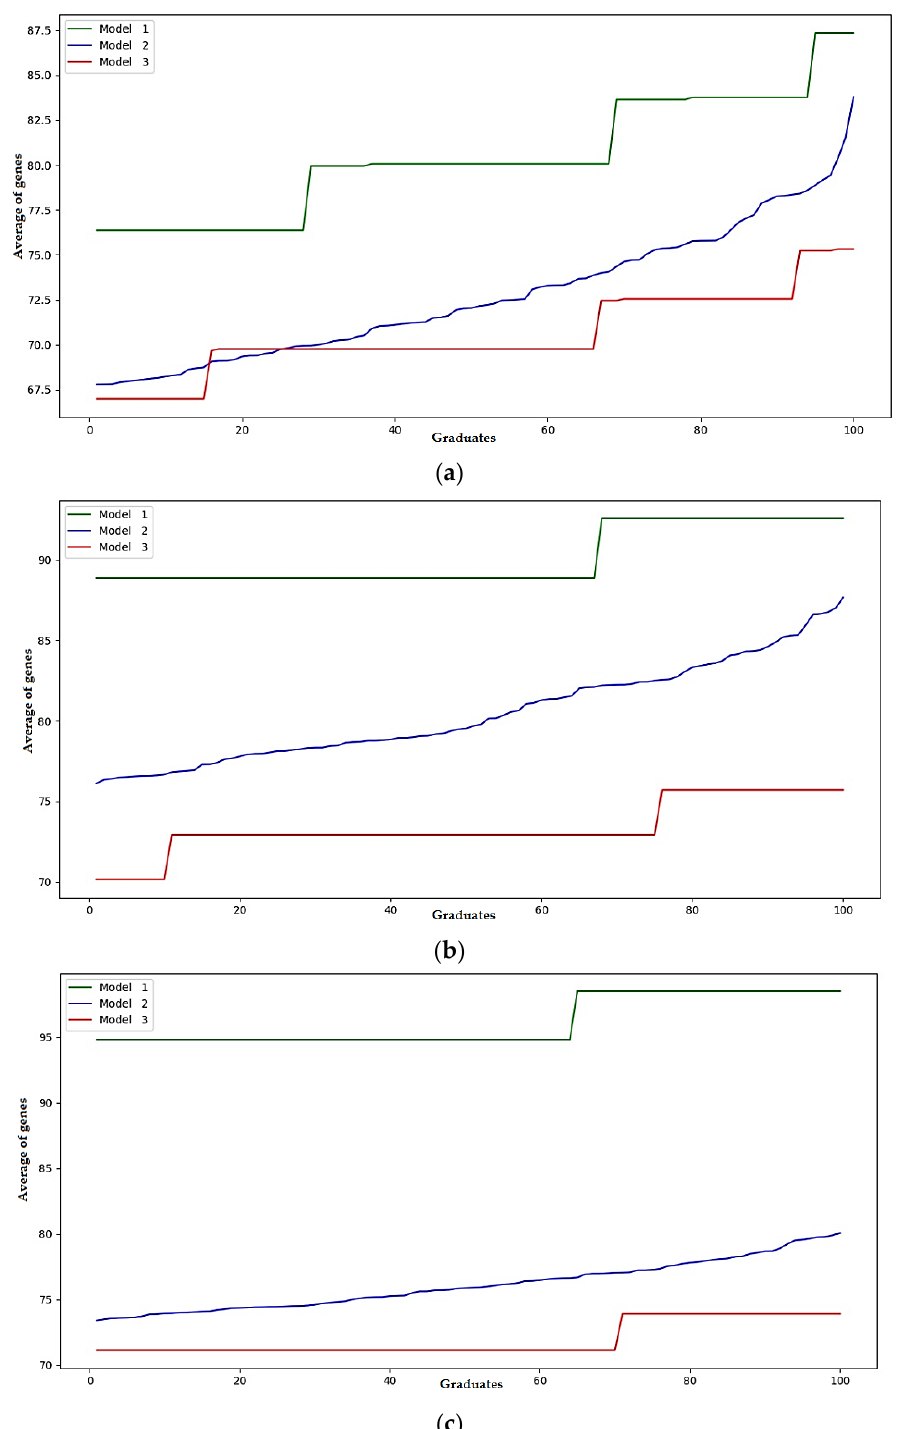
Figure 5. Prediction of career success according to the number of generations of the GA. ( a ) Prediction models with 100 iterations. ( b ) Prediction models with 200 iterations. ( c ) Prediction models with 300 iterations.